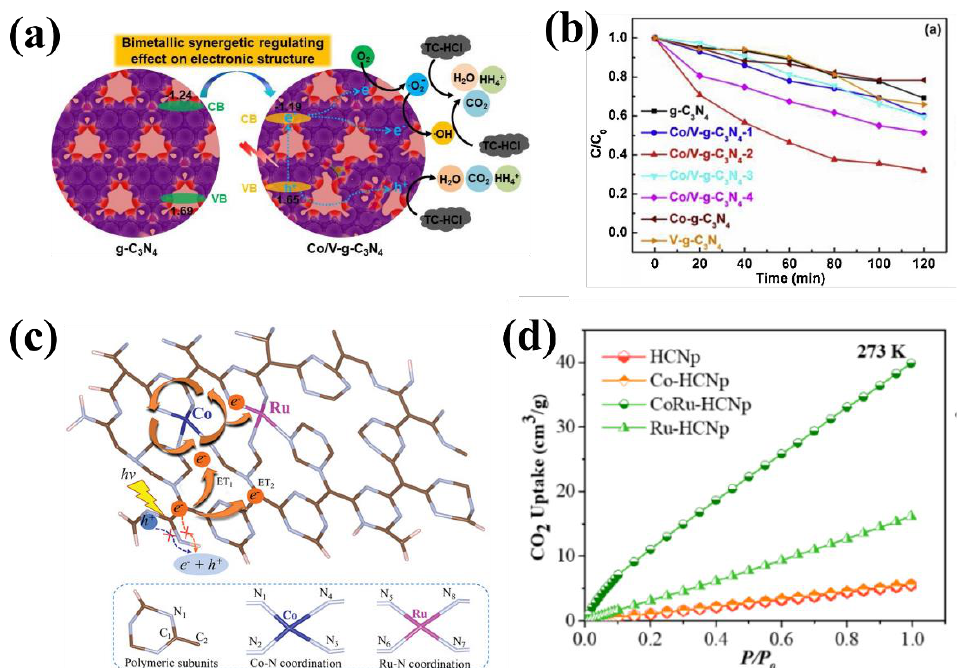
Figure 7. ( a ) The possible charge transfer behavior and reaction mechanism of Co/V – g – C 3 N 4 . ( b ) Kinetic curves of TC – HCl degradation over the different samples [51]. ( c ) Schematic illustration of doping structure and proposed dynamic photocarrier transfer mechanism in bimetallic Co-Ru-doped CN. ( d ) Comparison of CO 2 adsorption isotherms with different doped CN [52].